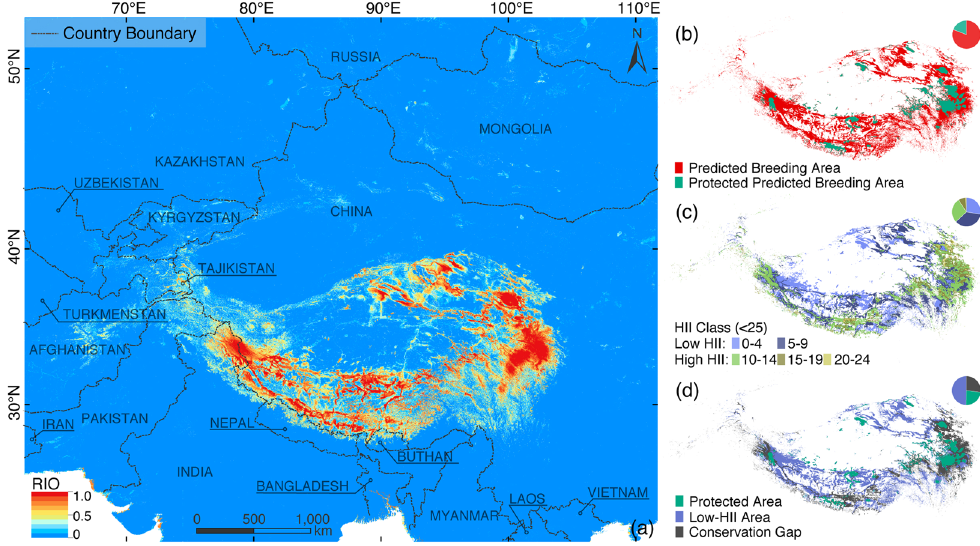
Figure 2. Prediction map, conservation status, anthropogenic pressures and conservation gaps. This map shows the black-necked crane’s ( a ) continuous prediction map in the study area, ( b ) conservation status analysis in predicted presence areas (RIO ≥ 0.58; binary prediction map overlaid with protected areas), ( c ) anthropogenic pressure analysis in predicted presence areas (RIO ≥ 0.58; map of Human Influence Index, HII) and ( d ) conservation gaps in its predicted presence areas (RIO ≥ 0.58). The maps were made by the authors in ArcGIS 10.1 (ERSI co., USA) and processed in Adobe Illustrator CC (Adobe Systems Inc.,